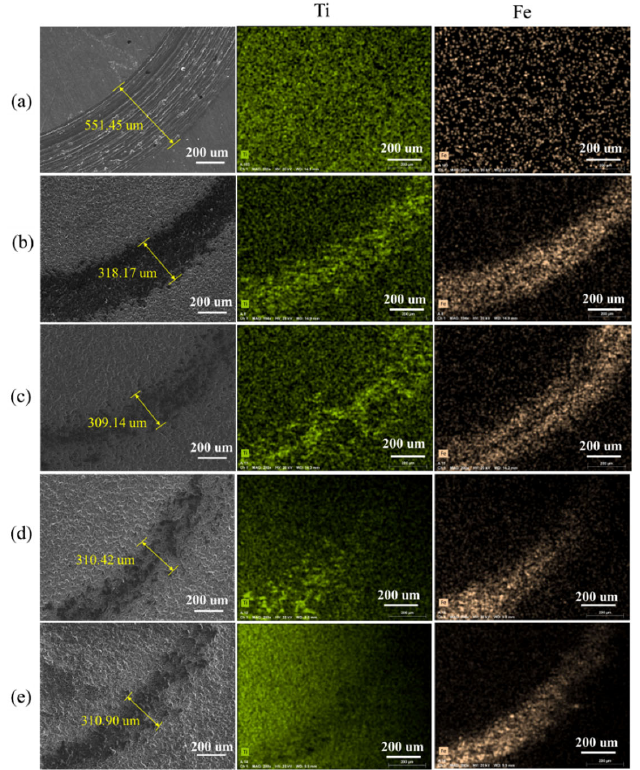
Figure 6. The surface SEM and EDS of TC4 and MAO-Cu/Cu-(HEA)N composite coatings with different CuSO 4 concentrations: ( a ) TC4; ( b ) 0 g/L; ( c ) 5 g/L; ( d ) 10 g/L; and ( e ) 15